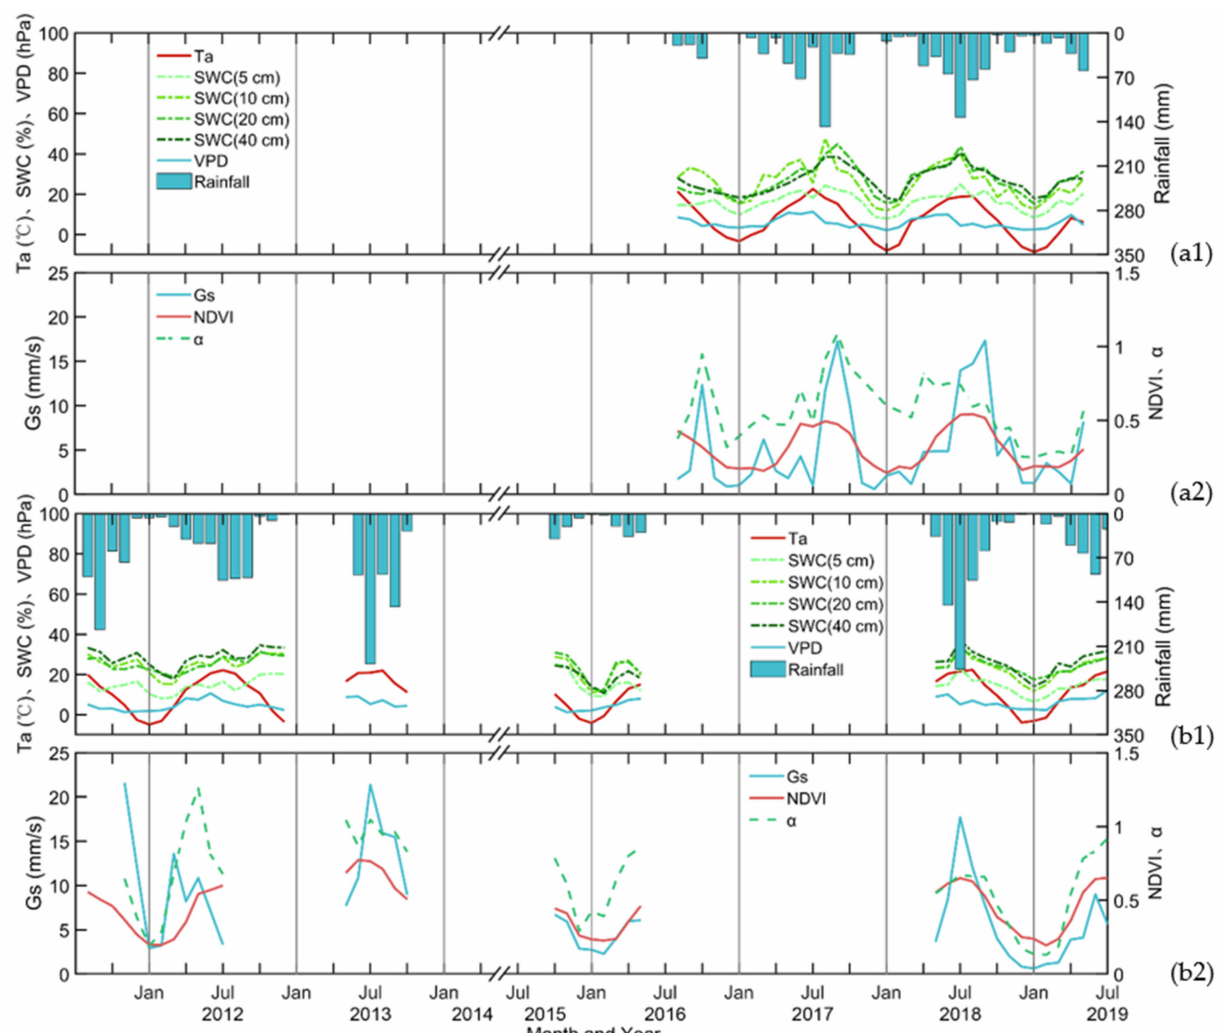
Figure 3. Seasonal and interannual variations of eco-environmental factors at Dingxi ( a1 , a2 ) and Qingyang ( b1 , b2 ) stations. Ta is the monthly mean temperature, SWC is the soil water content, VPD is the vapor pressure deficit, Rainfall represents monthly precipitation, Gs is the canopy stomatal conductance, α is the Priestley–Taylor coefficient, and NDVI is the normalized vegetation